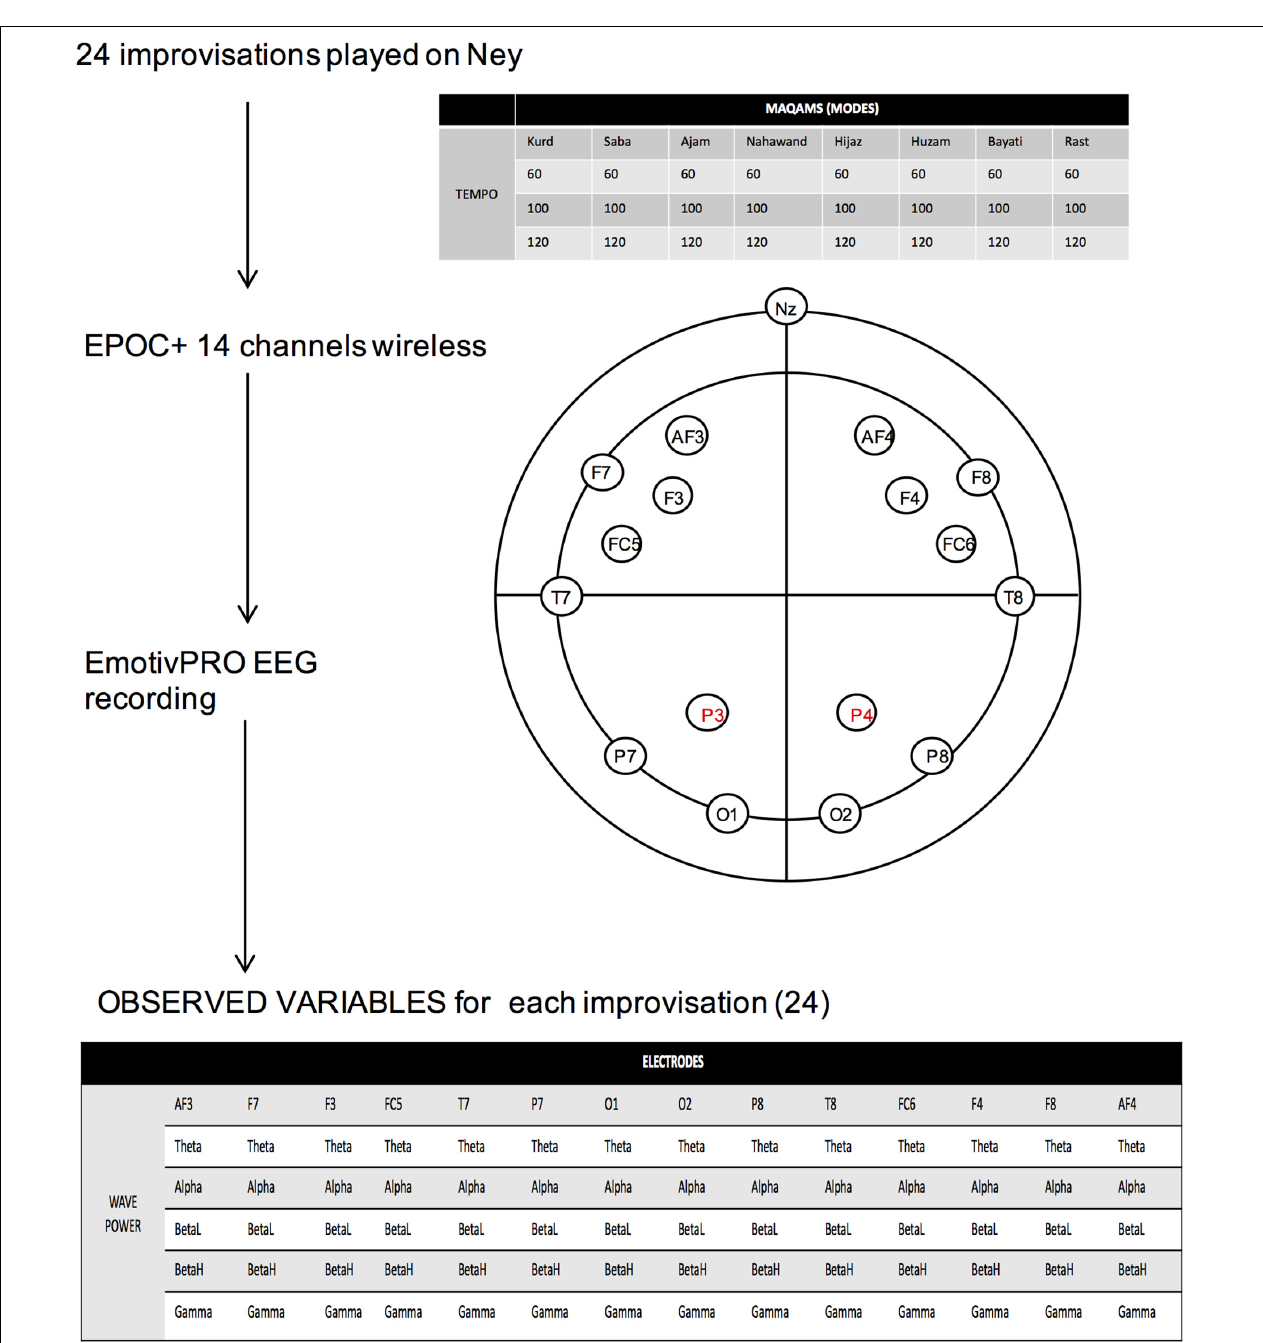
FIGURE 1 | Study design. Detail of the 24 improvisations played and the 14 electrode positions, as well as the variables observed for each improvisation.